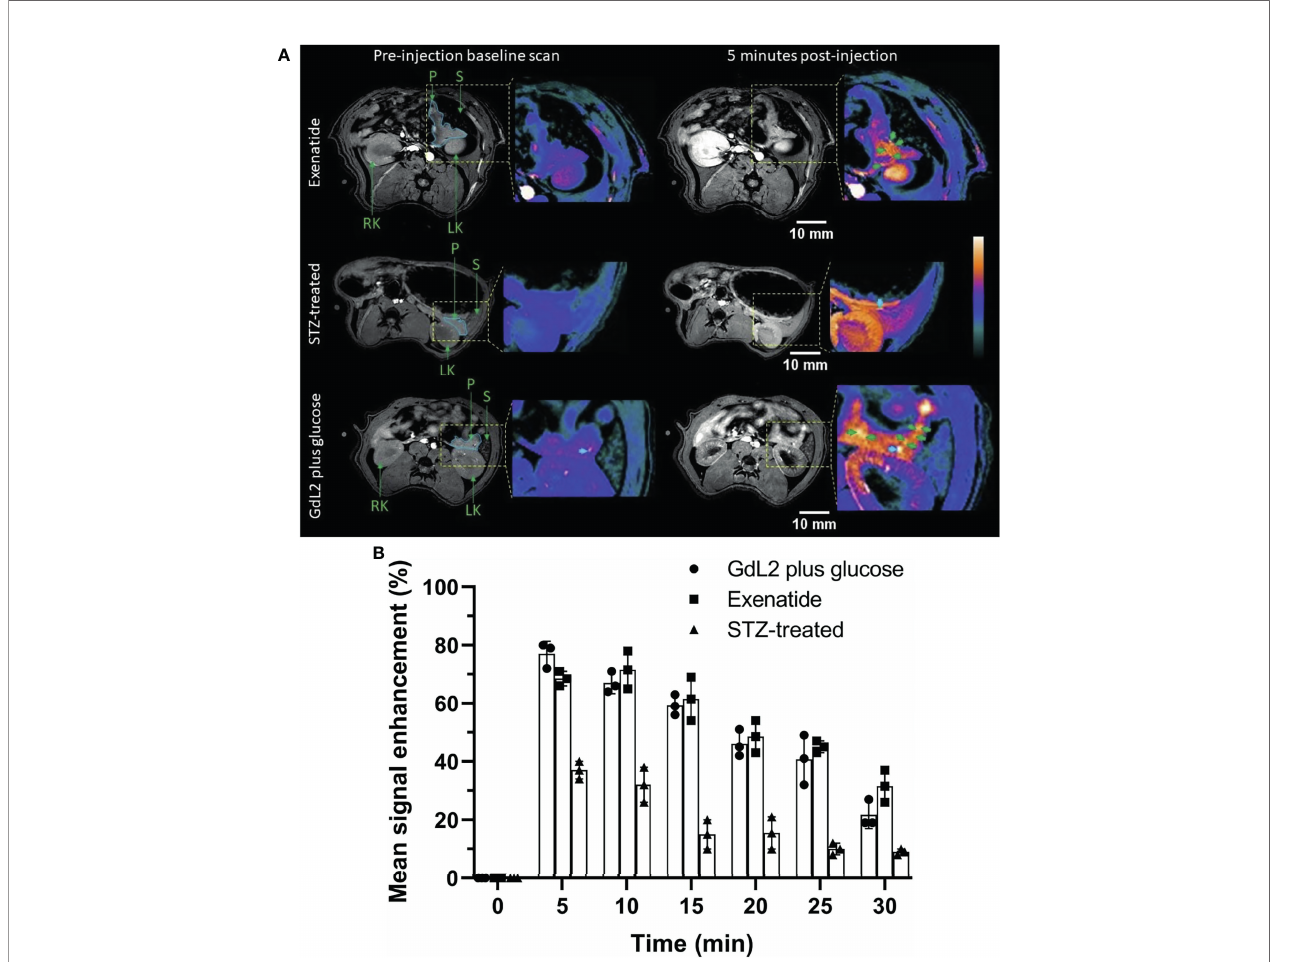
FIGURE 4 | (A) Representative MRI images of exenatide and STZ-treated rats. Exenatide (top row) results in sustained pancreas tail enhancement with focal hot spots. In contrast, rats treated with STZ showed signi fi cantly reduced signal enhancement in the pancreas tail and no hot spots. (B) Comparison of pancreatic tail signal enhancement (SE) in control rats, STZ-treated rats (Type 1 diabetes model), and exenatide-treated rats. All rats were given the same dose of GdL 2 (0.1 mmol/ kg) and glucose (2.75 mmol/kg dextrose) prior to imaging. STZ results in signi fi cant reduction in SE compared to control and exenatide groups. The individual data points in (B) are shown as the mean ± SD.